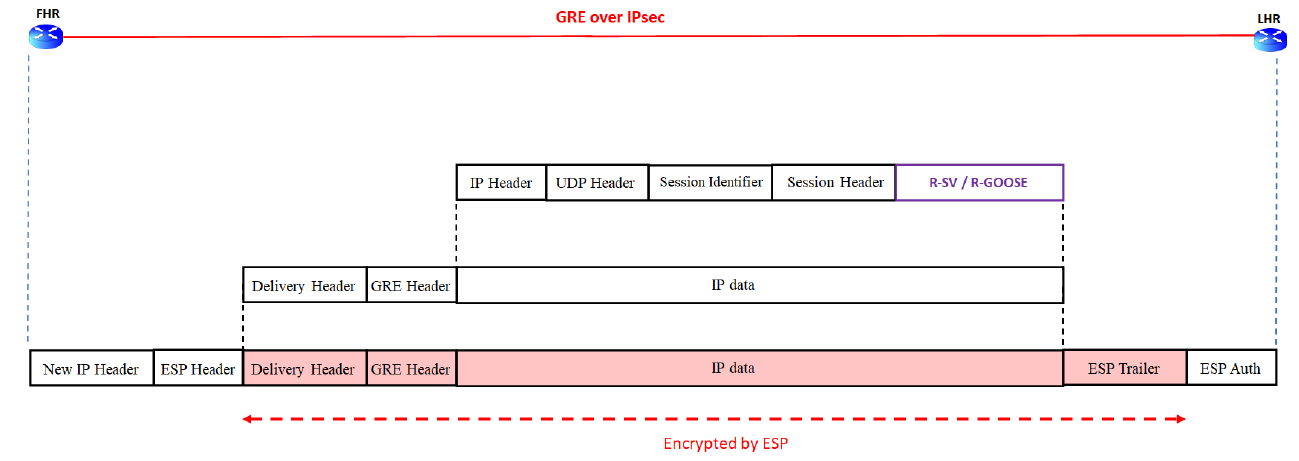
Figure 16. Non-secured R-SV/R-GOOSE messages encapsulated by GRE and secured by ESP over IPsec tunnel between edge routers.